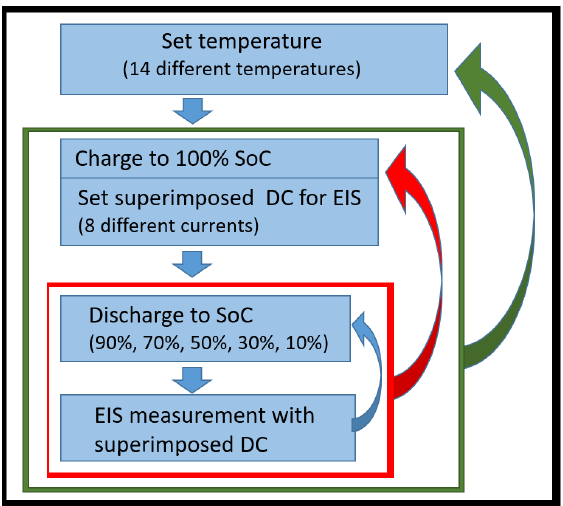
Figure 5. Procedure of data